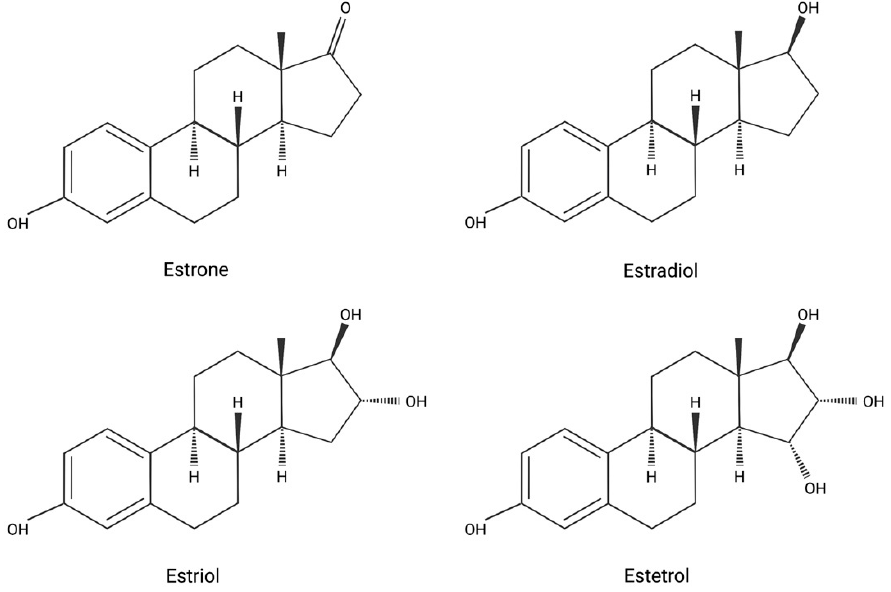
Figure 1. Molecular structure of different estrogens. Created with BioRender.com (4 September 2021).